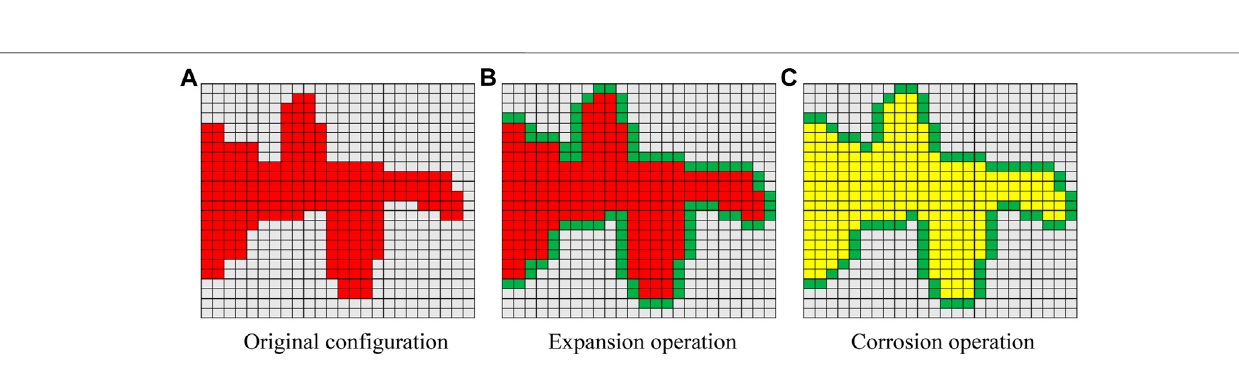
FIGURE 5 | Schematic diagram of open operation (FISHMEMORY, 2016). (A) Original con fi guration, (B) corrosion operation, and (C) expansion operation.